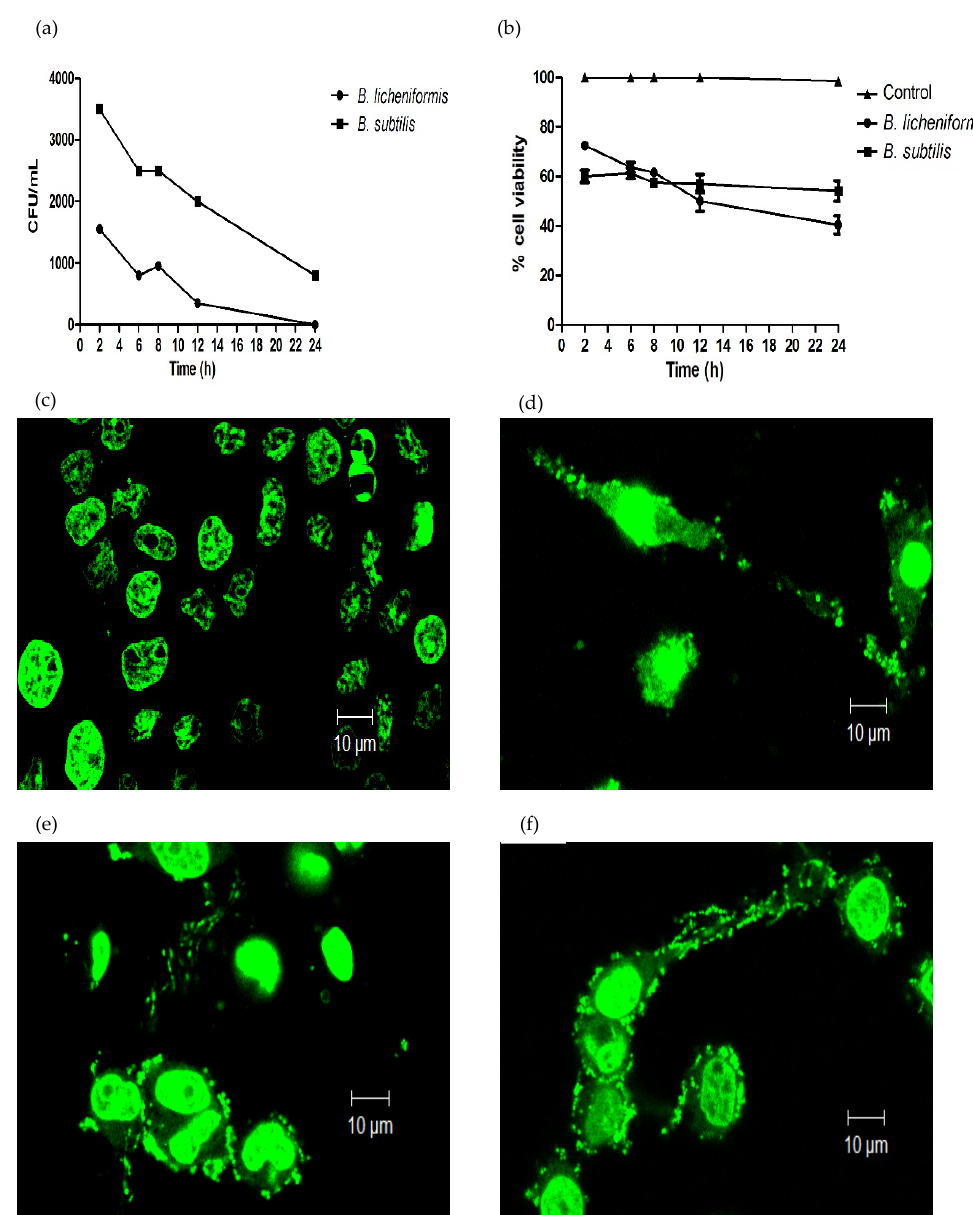
Figure 1. Macrophages of the J774A.1 cell line. When infected with Bacillus licheniformis and Bacillus subtilis , they die as a result of infection and produce METs. ( a ) Intracellular B. licheniformis and B. subtilis colony-forming units were determined at different infection times. ( b ) Macrophage cell viability was determined by the trypan blue exclusion assay at different infection times. As a consequence of the infection, there were nuclear and cellular changes, which were evidenced by Sytox Green staining after 3 h of infection and observed by confocal microscopy ( c ) Control cells. ( d ) Zymosan treated cells. ( e ) B. licheniformis and ( f ) B. subtilis. 630 × magnification. Representative results of three experiments.